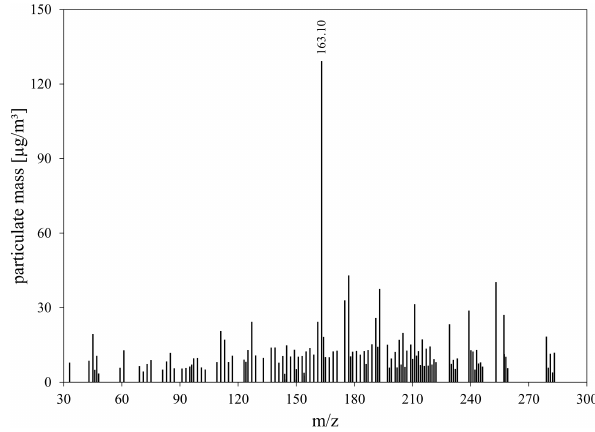
Figure 6. PTR-ToF-MS mass scan obtained when 10-fold diluted cigarette smoke was sampled through the CHARON inlet. The prominent peak at m/z 163.12 (C 10 H 14 N + nated nicotine. Note that the particulate mass is enriched by a factor ∼